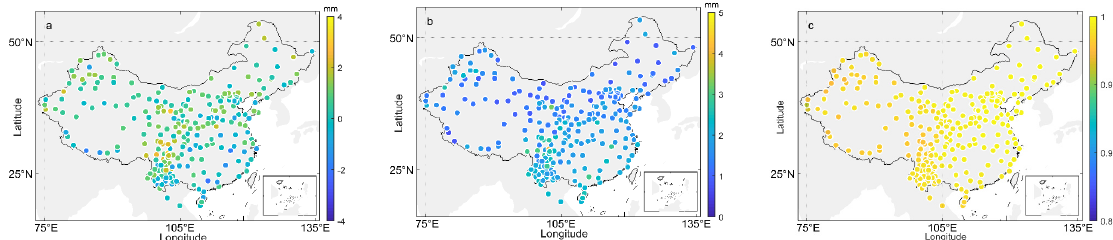
Figure 3. ( a ) Bias, ( b ) RMS, and ( c ) correlation coefficient between GNSS-PWV and ERA-PWV in the six-year period studied from 2013 to 2018 over each of the 246 GNSS stations.